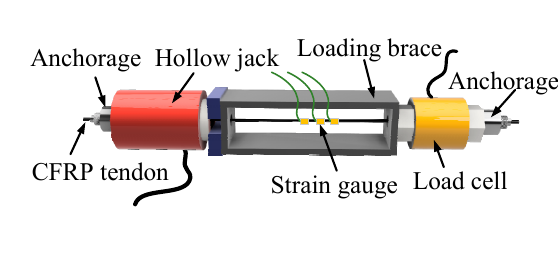
Figure 2. Static test setup.